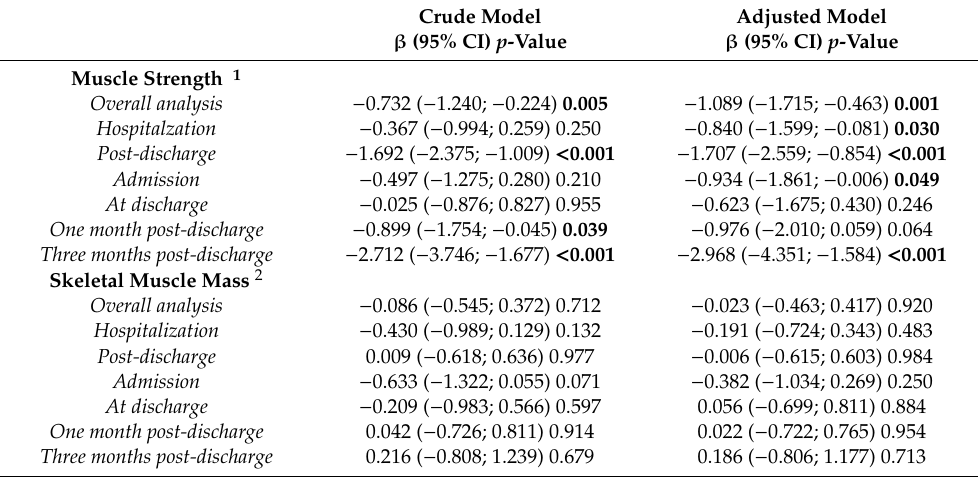
Table 3. Longitudinal associations of decreased appetite and muscle strength, skeletal muscle mass, mobility, and physical performance, crude and adjusted for